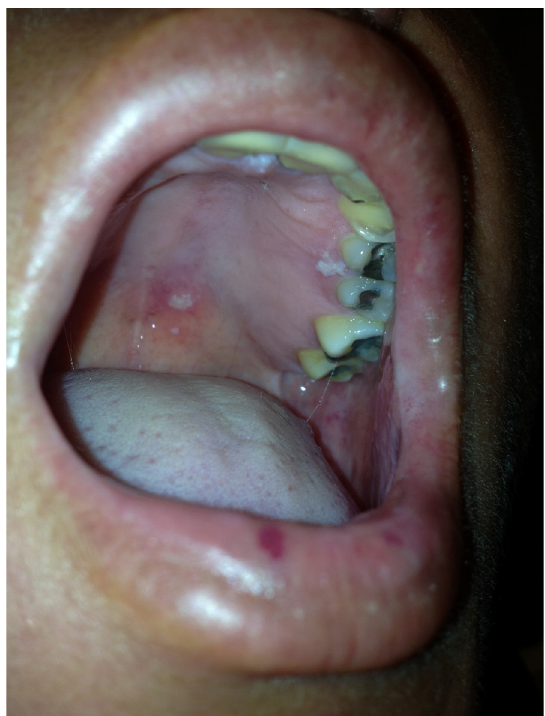
Figure. Multiple vesicles on the palate